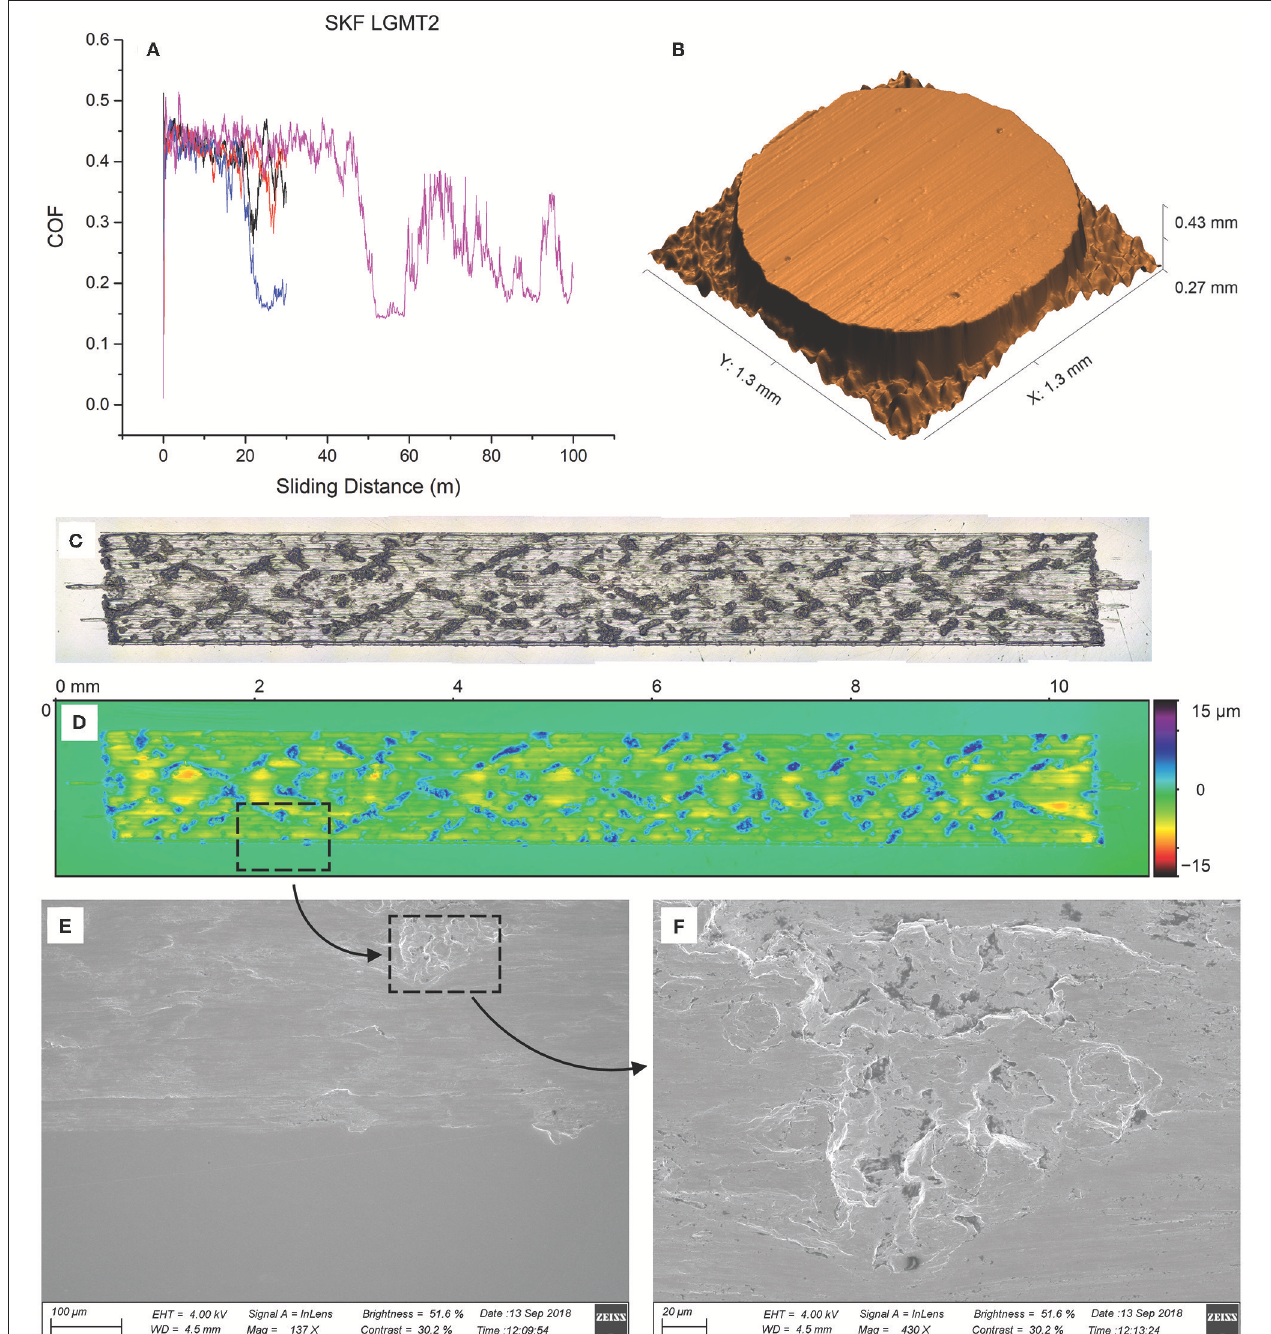
FIGURE 2 | Test results for SKF LGMT2 including (A) friction traces, (B) interferometer image of the ball wear scar, (C,D) optical microscope and interferometer images of the flat wear scar, and (E,F) SEM micrographs of the flat wear scar. All wear images correspond to the test shown in blue in (A) .